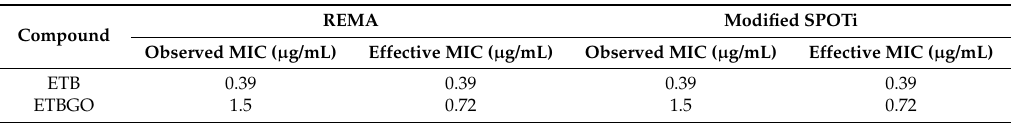
Table 1. The minimum inhibitory concentration of the compounds tested based on the liquid culture REMA assay with M. smegmatis